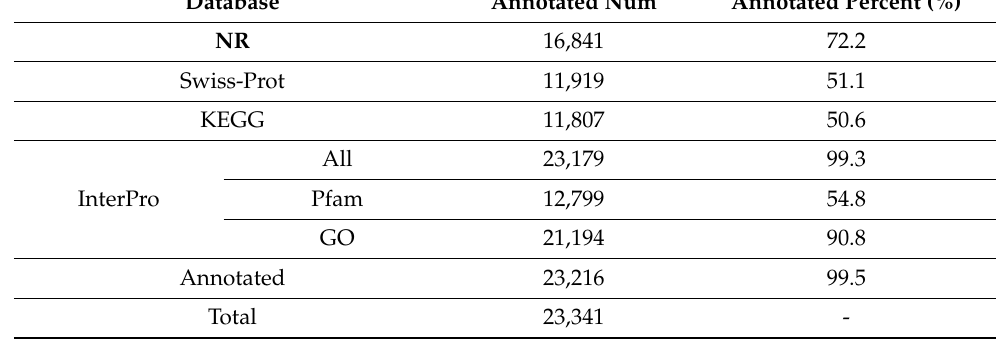
Table 7. The statistical results of gene function annotation of C. roscoffensis genome.